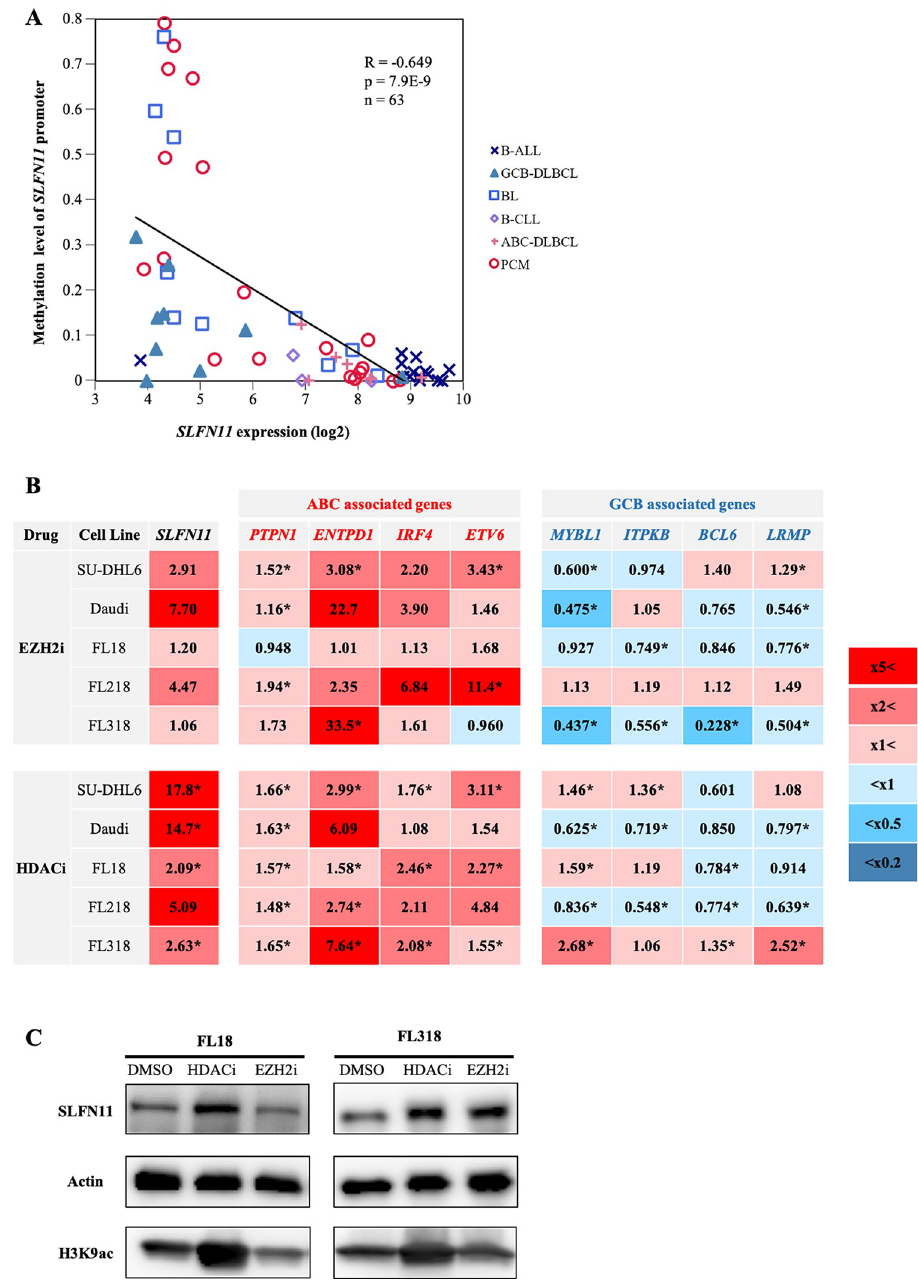
Fig 4. Tazemetostat and panobinostat upregulate the expressions of SLFN11 and ABC-DLBCL-associated genes in GCB-derived lymphomas. (A) DNA methylation level of SLFN11 promoter in B-cell-derived cancer cell lines. X- axis represents SLFN11 mRNA expression (log2) and Y-axis represents DNA methylation level of the SLFN11 promoter. B-ALL, B-cell acute lymphoblastic leukemia (n = 14); GCB-DLBCL, germinal center B-cell like-diffuse large B-cell lymphoma (n = 9); BL, Burkitt lymphoma (n = 10); B-CLL, B-cell chronic lymphocytic leukemia (n = 3); ABC-DLBCL, activated B-cell like-diffuse large B-cell lymphoma (n = 8); PCM, plasma cell myeloma (n = 19). Pearson’s correlation (R), P-value (p), number of the samples (n) and regression line (black line) are shown. (B) Heatmap of fold changes (treated/untreated) of ABC- and GCB-DLBCL-associated genes. Cells were treated with tazemetostat (5 μ M, 4 days) or panobinostat (10 nM, 16 hours) and the gene expression levels were measured by quantitative RT-PCR. Results are the average of three independent experiments. � p < 0.05 (two-sided paired t-test). (C) Western blotting of SLFN11, H3K9ac and Actin in FL18 and FL318 treated with tazemetostat (5 μ M, 16 hours) or panobinostat (10 nM, 16 hours).